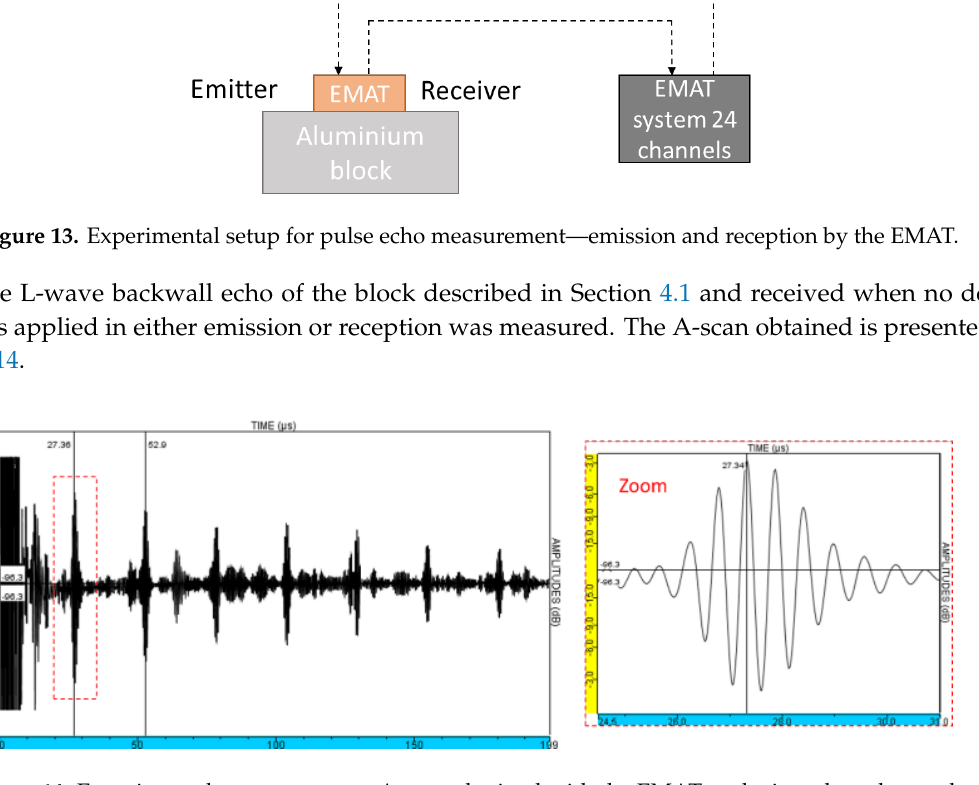
Figure 14. Experimental measurements: A-scan obtained with the EMAT probe in pulse echo mode. No focusing, aluminum block of 80 mm.